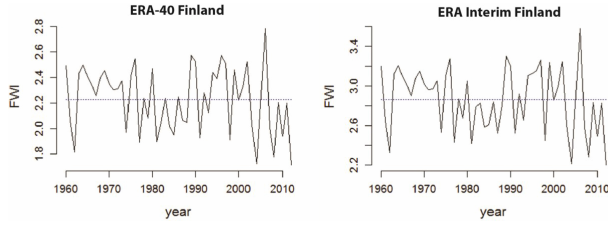
Figure 10. FWI time-series data based on ERA-40 and ERA Interim for Finland. Blue lines represent the mean values of